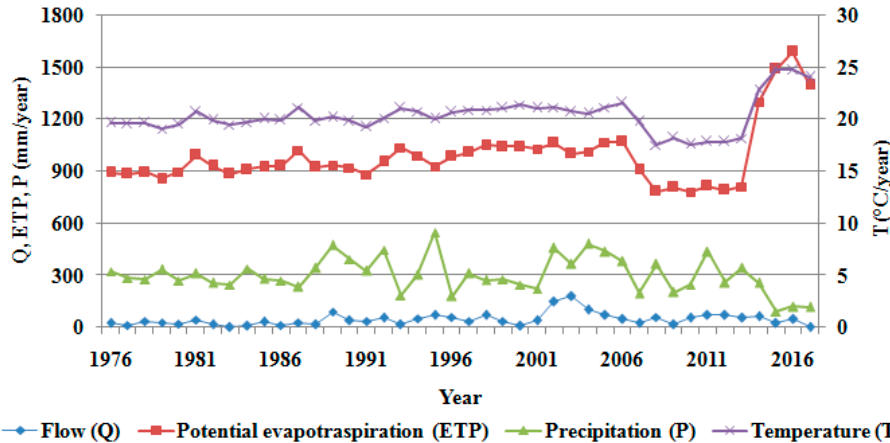
Figure 3. Annual variability of different hydroclimatic variables in the Merguellil Wadi.